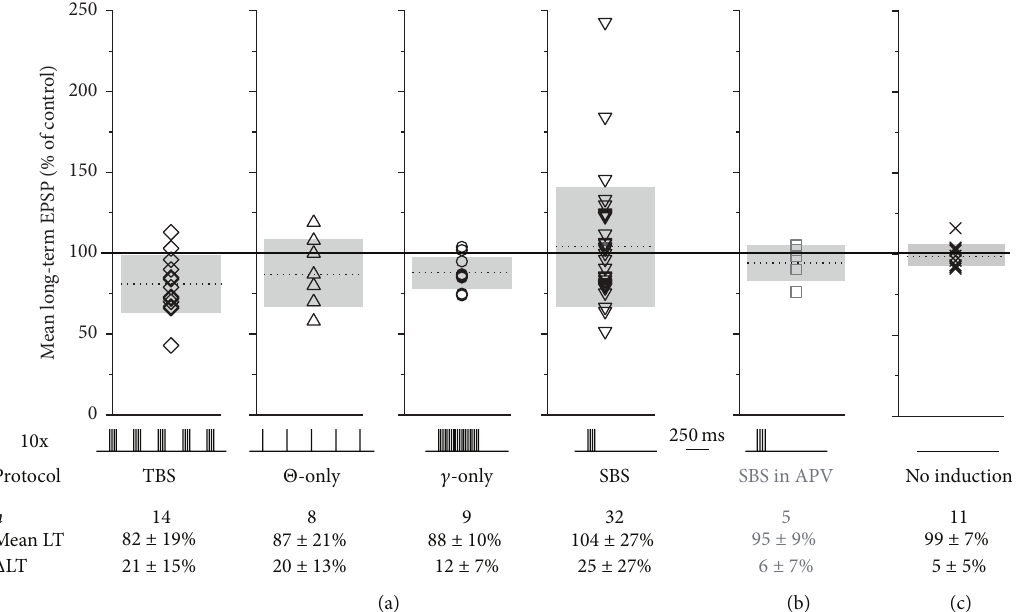
Figure4:Synopsisofplasticityexperiments.SBSplasticityisNMDAR-dependent.Bottom:temporalsequenceofinductionprotocol,number of experiments, average long-term plasticity (mean LT), and average efficiency of long-term plasticity induction ( Δ LT, absolute value of plastic changes). All data ± SD. (a) Cumulative display of mean long-term change for all induction protocols with individual data sets, means (dotted lines), and SD (extent of grey bars). (b) Mean long-term change of SBS experiments in the presence of 25 𝜇 M APV. Note the substantially reduced variance. (c) Mean long-term change of experiments without induction ( 𝑛 = 11: 5 without induction and 6 recorded from heteroglomerular control channel that was not induced with SBS; see Figure